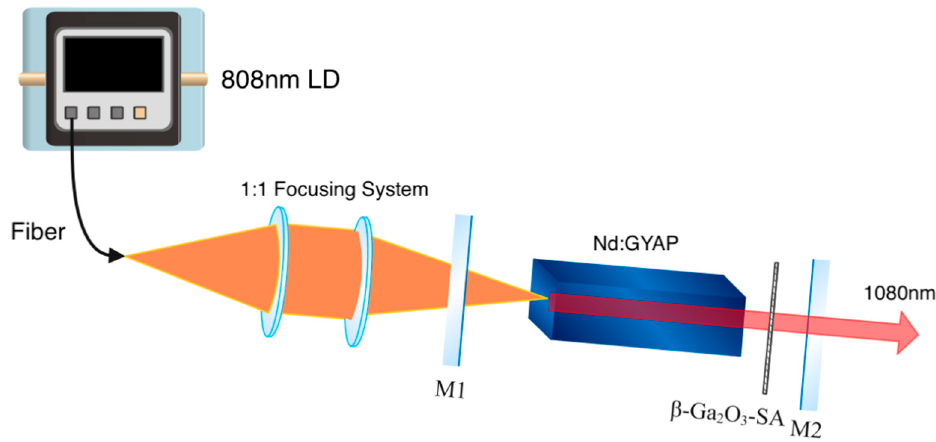
Figure 4. Schematic experimental setup of the β -Ga 2 O 3 SA Q-switched Nd:GYAP laser.